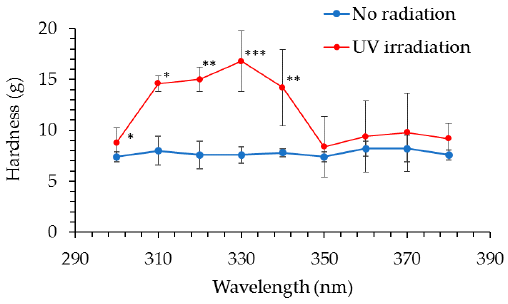
Figure 6. Dynamic spectrum of the hardness of collagen gels irradiated with UV rays measured by the Rheo TEX SD -700. n = 5, Mean ± S.D., * p < 0.05 vs. 0 J/cm 2 , ** p < 0.01 vs. 0 J/cm 2 , *** p < 0.001 vs. 0 J/cm 2 .